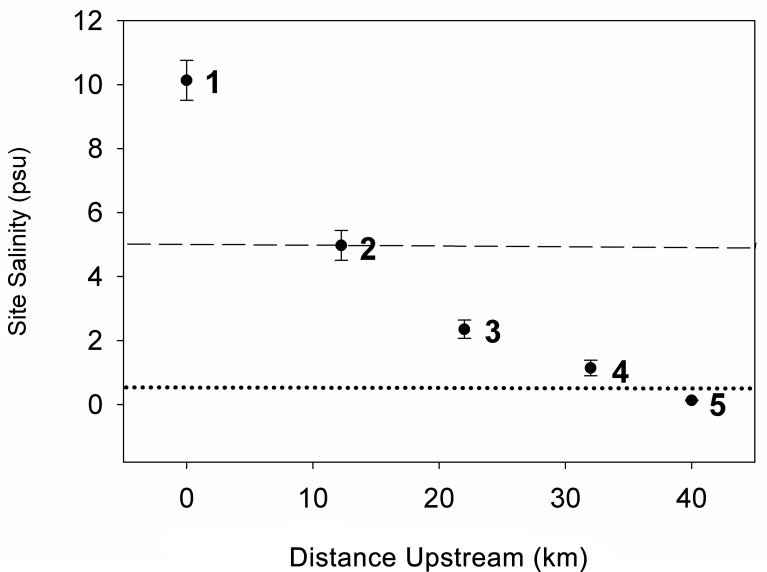
Salinity of study sites on the Nanticoke subestuary.Plotted values are mean ± 1 SE of measurements of marsh surface water and porewater salinity from 2007–2011 (n = 33–39 for each site mean). Porewater measurements were taken at 10–20 cm depths adjacent to surface elevation tables. Distance upstream is distance from Site 1 (0 km upstream). Dashed line represents the oligohaline-mesohaline salinity boundary (5) and dotted line represents the fresh-oligohaline boundary (0.5). Sites are numbered 1–5.